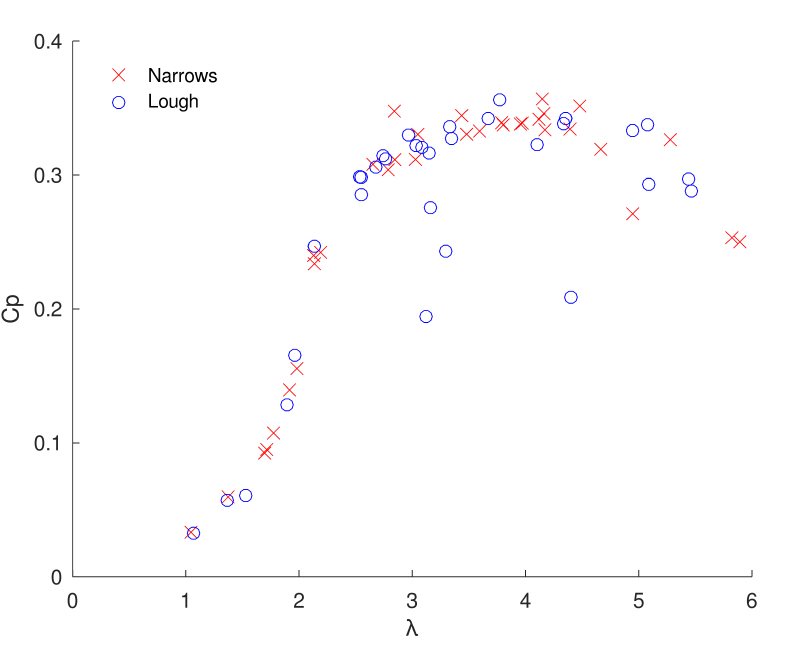
Figure 11. C p – λ data based on filtered steadiest 30 s samples from V1, classified by location, Narrows (energetic) or Lough (still